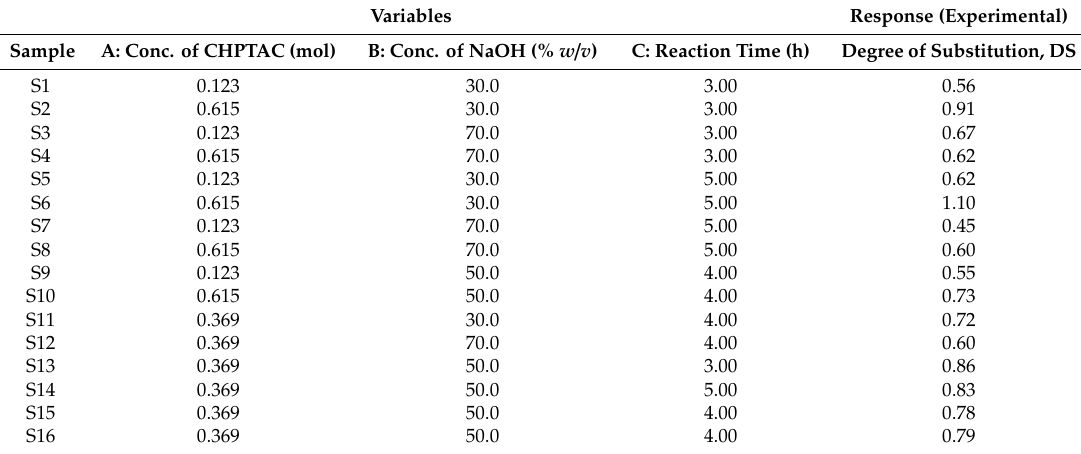
Table 1. Central composite design (CCD) for cationization of sago starch experimental degree of substitution response